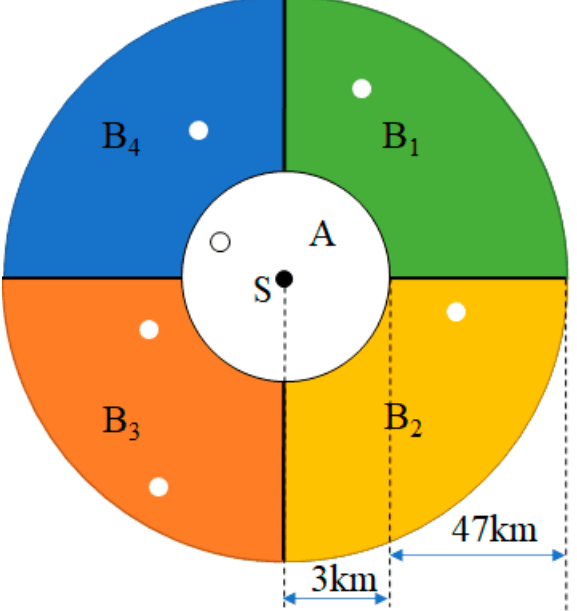
Figure 4. Neighborhood partitioning and diffusion for Station S.